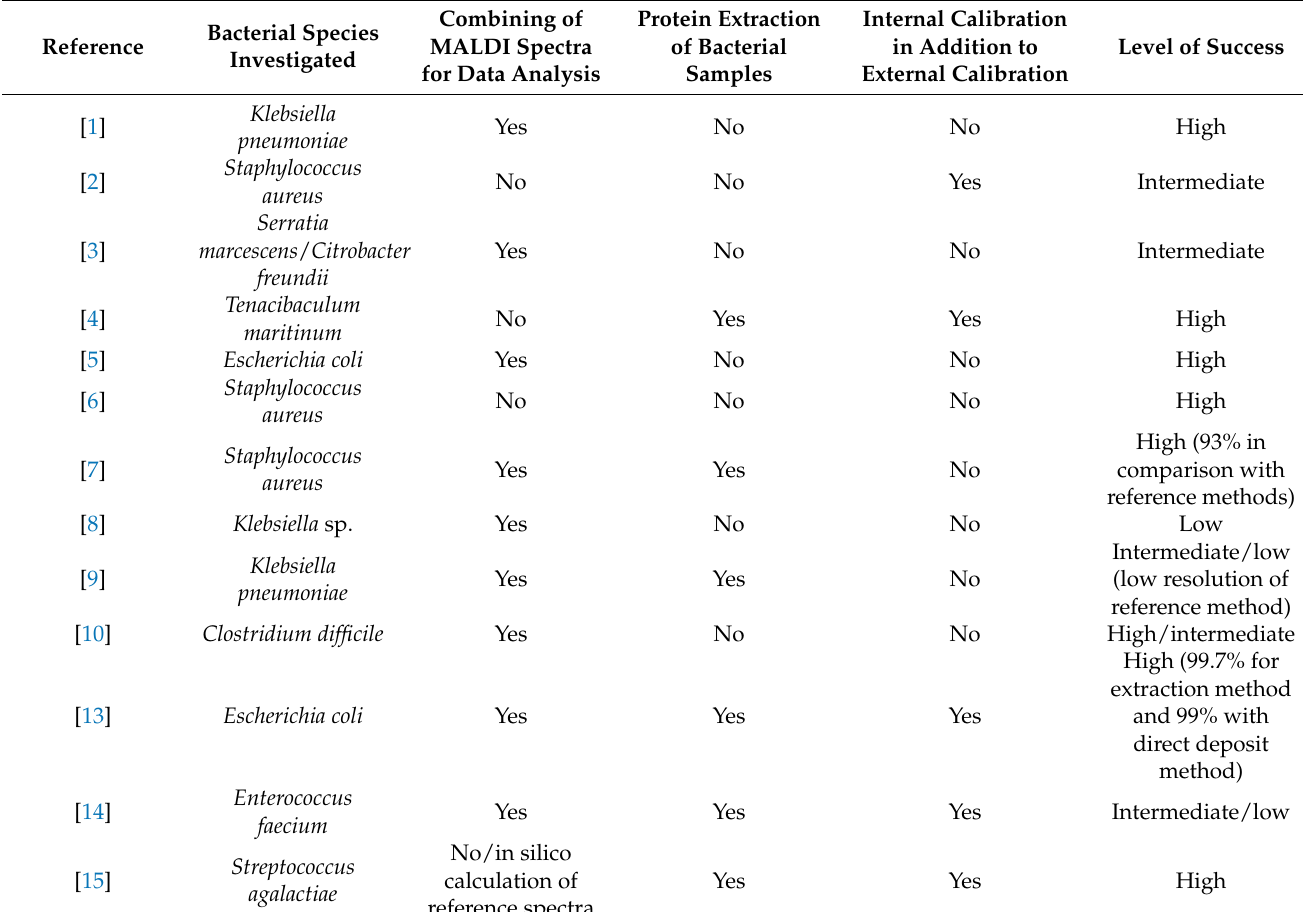
Table 1. Methods shared amongst multiple studies and levels of success of each